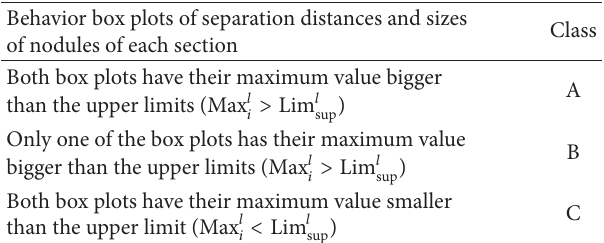
Table 2: Summary of the second phase of the section classifying algorithm.